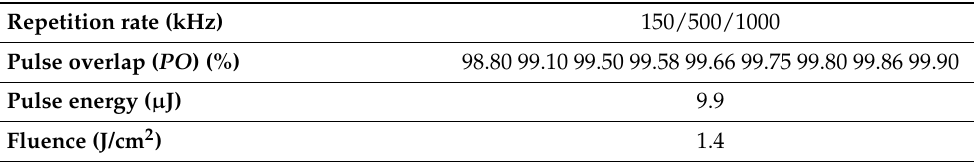
Table 1. Laser parameter variations used for Ti alloy texturing.